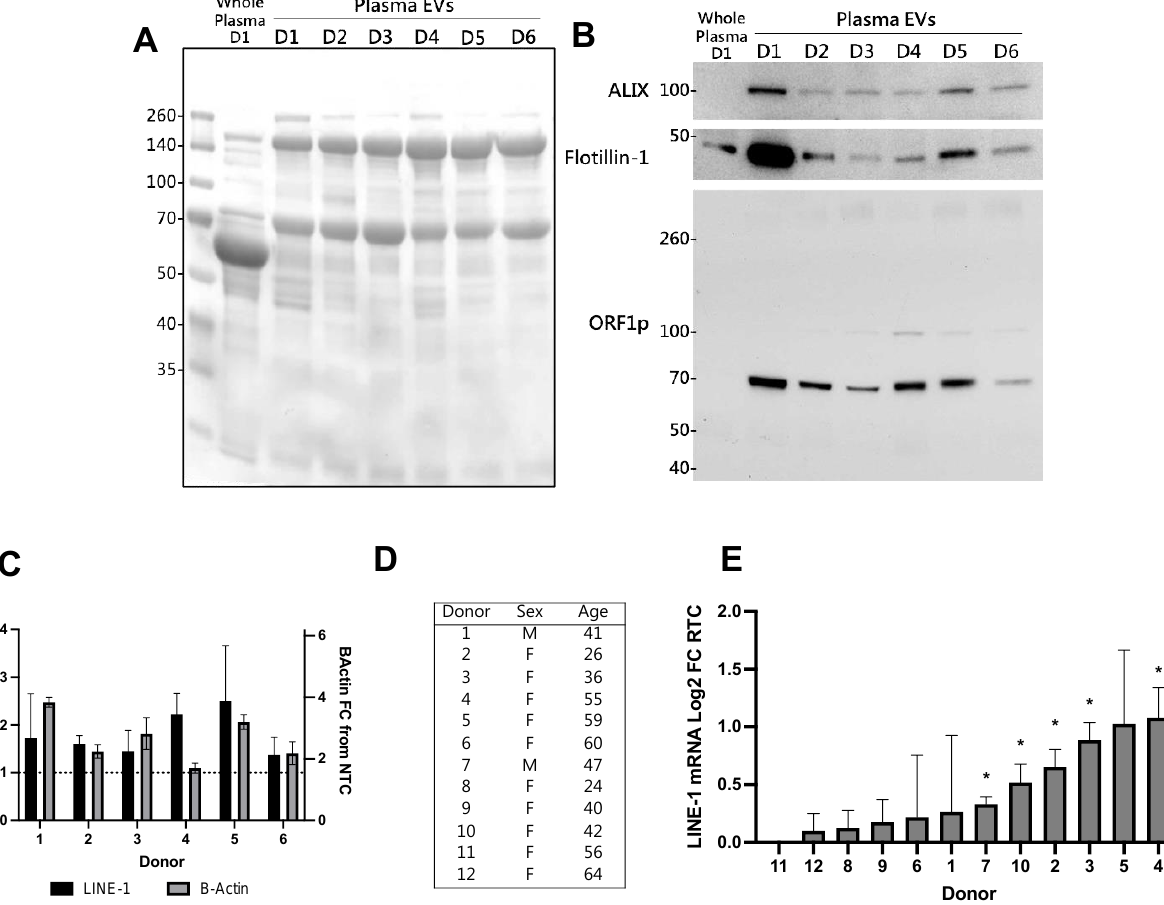
Figure 5. Extracellular vesicles (EV) Long Interspersed Element-1 (LINE-1) levels in individual human plasma donors. LINE-1 mRNA and ORF1p levels were quantified in ostensibly healthy donors using plasma volumes that could be commonly acquired by venipuncture. For each donor, EVs were isolated from 2.5 mL plasma via ultracentrifugation. Thirty micrograms of EV protein from six different donors (D1–D6) was used for Western blotting. ( A ) Ponceau staining of the membrane demonstrates equal protein loading. Whole plasma from Donor 1 was included as a reference. ( B ) Immunoblot of EV proteins and ORF1p. ( C ) RNA was extracted from EVs and then subjected to One-Step RT-qPCR. Mean, SEM shown. To examine LINE-1 mRNA expression more closely, mRNA levels from all donors used in this study were converted to log2 FC values ( D , E ) and a one-sample t-test was used to determine if levels were significantly greater than zero (* p < 0.05).